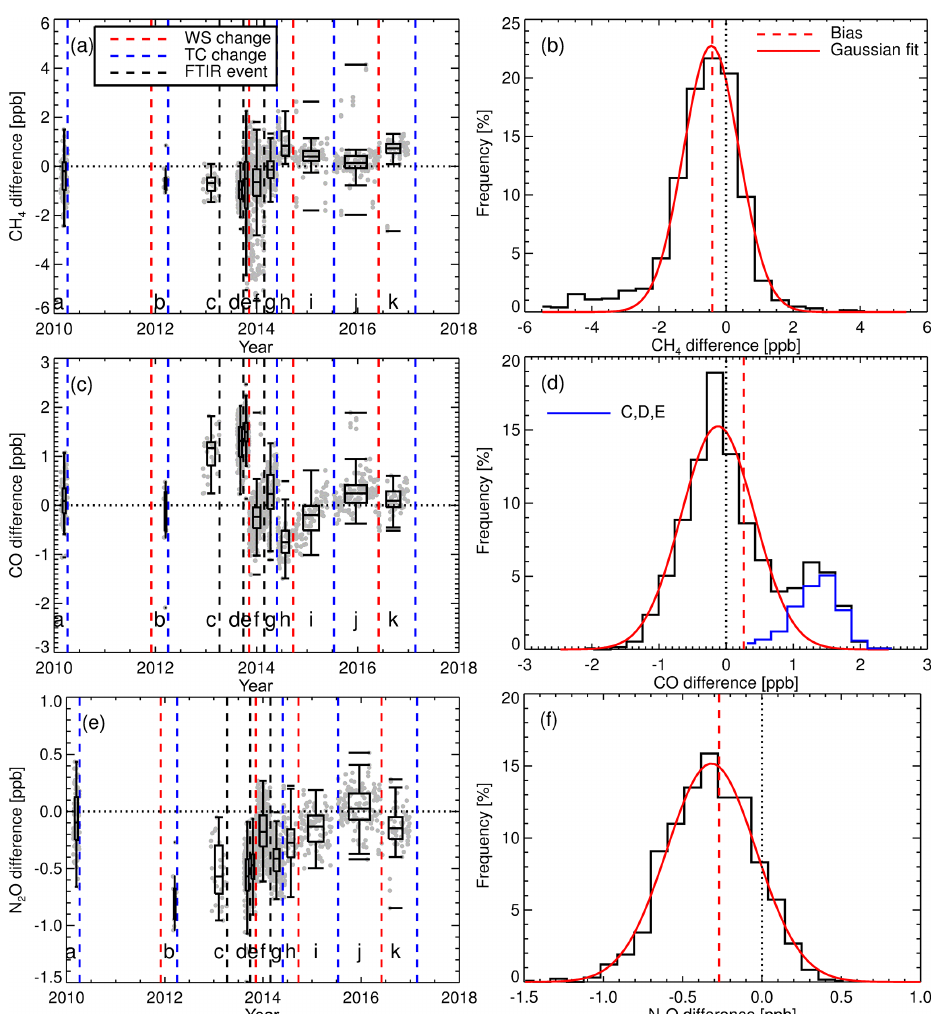
Figure 11. (a) The grey data points show the difference between TC CH 4 measurements and that of the TC assigned values (FTIR-TC). The blue dashed vertical lines indicate TC change. The red dashed vertical lines indicate the WS change. Black dashed vertical lines indicate a significant instrument event. The intervals between changes have alphameric labels. Box plots display interval summary statistics. (b) His- togram of FTIR-TC flask differences over all intervals. The dashed vertical red line is the mean difference (bias). The red line is a Gaussian fit to the histogram to illustrate the deviation of the differences from that of a theoretical random Gaussian statistical distribution based on the given data set. Panels (c) and (d) show the same as (a) and (b) but for CO. In (d) , the additional blue histogram relates to intervals C, D and E. Panels (e) and (f) show the same as (a) and (b) but for N 2